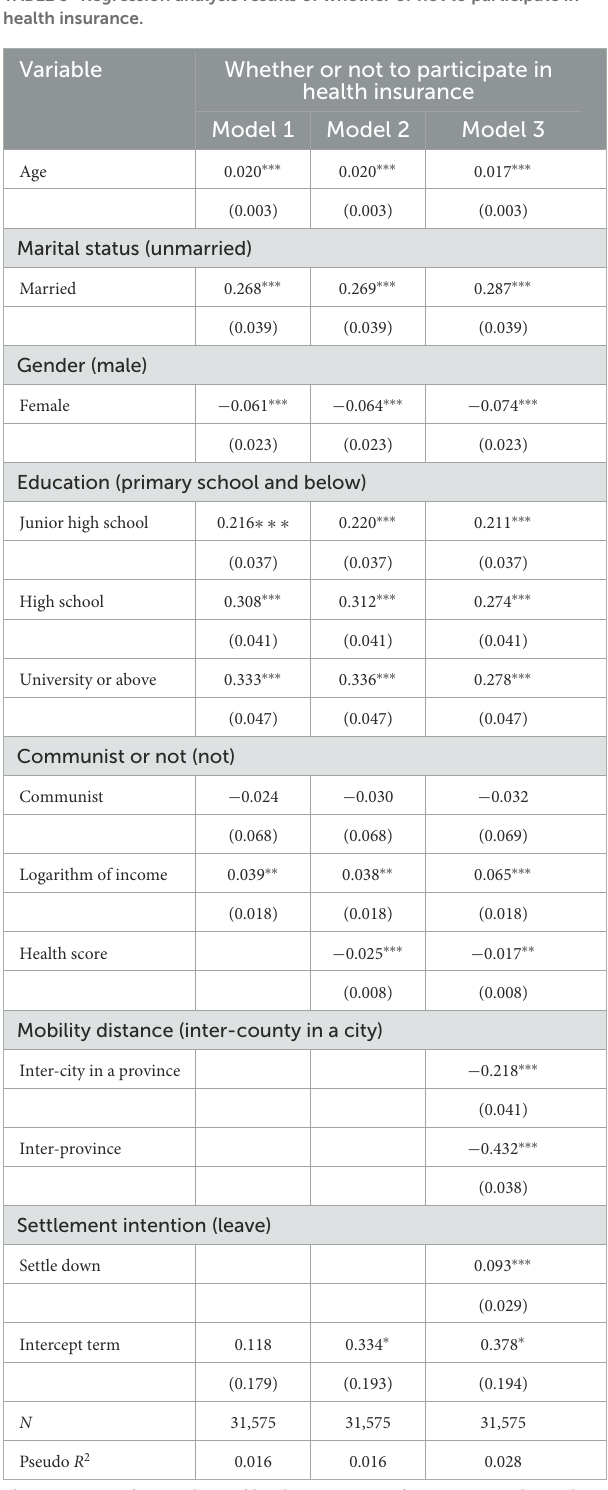
TABLE 4 Regression analysis results of health insurance type